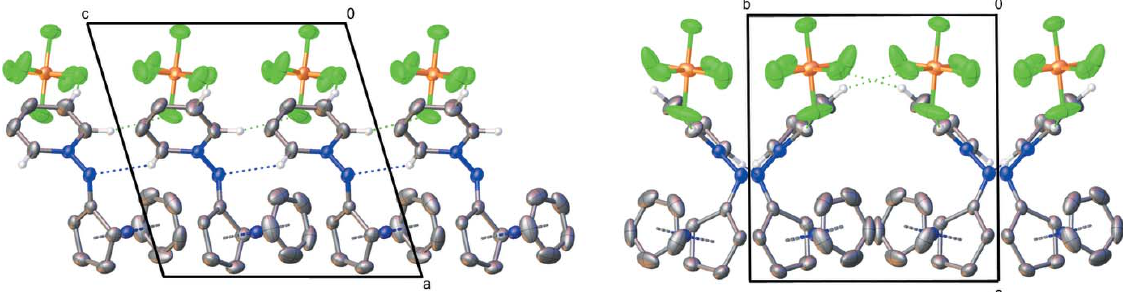
Figure 3 Formation of the hydrogen bonds of the title compound, with displacement ellipsoids drawn in at the 50% probability level for non-H atoms. Hydrogen bonds are represented by dashed lines (H (cid:5)(cid:5)(cid:5) N blue, H (cid:5)(cid:5)(cid:5) F green). Hydrogen atoms not involved in hydrogen bonds are omitted for clarity. Left view along the b axis, right view along the c axis.